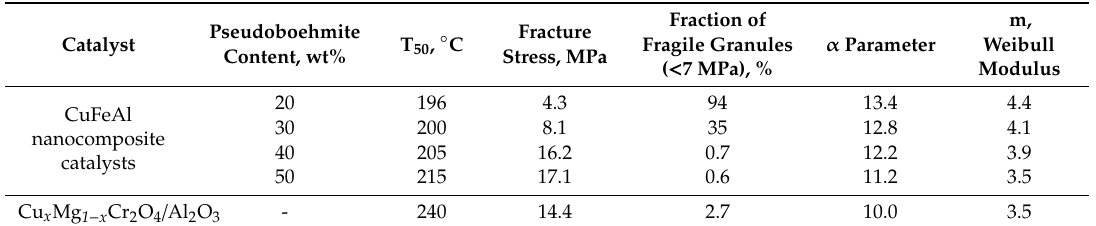
Table 3. Catalytic and mechanical properties of the CuFeAl composite and Cr-containing